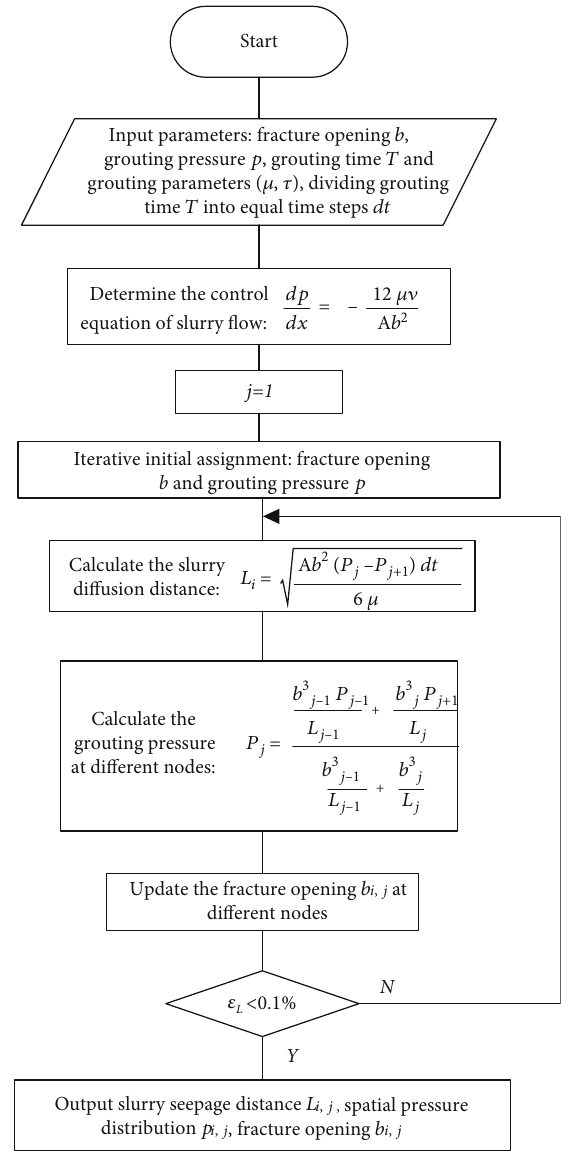
Figure 5: Flow chart of the step-wise